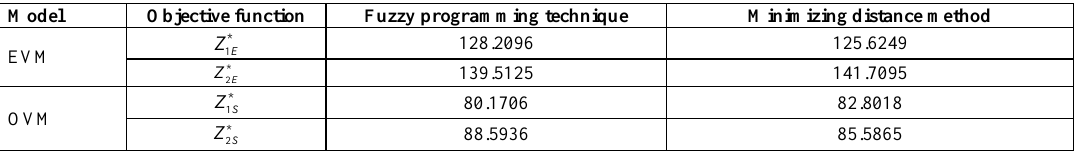
Table 5. Comparison of the results obtained with FPT and